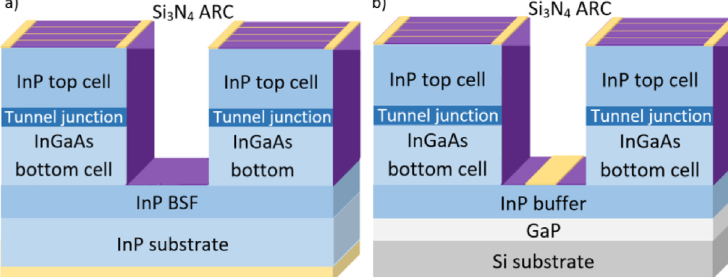
Fig. 1. Sketch of the tandem solar cell fabricated on InP (a) and on Si (b) Substrates, respectively. The tandem on Si back contact is shown as a bus-bar located in the perimeter since the contact cannot be directly made on the back of the sample, it is deposited on the bottom of the mesas (on n + InP buffer), between each cell.